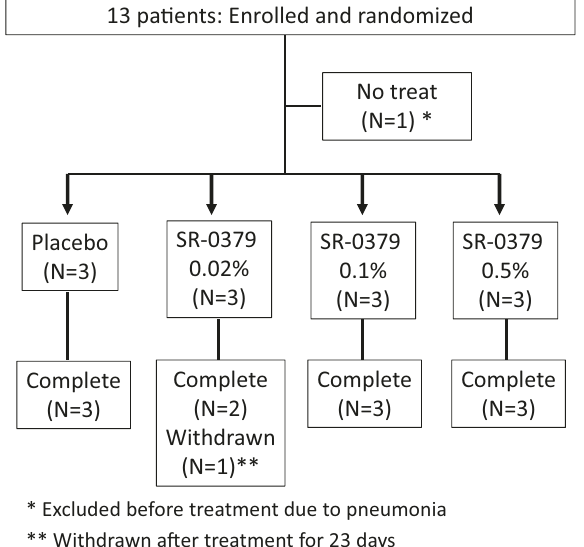
Fig. 1 Trial pro fi le of patients. One patient (0.02%) stopped skin ulcer treatment with SR-0379 at day 23 and was withdrawn at day 24. The patient was judged to be included in the FAS for the ef fi ciency and safety evaluation